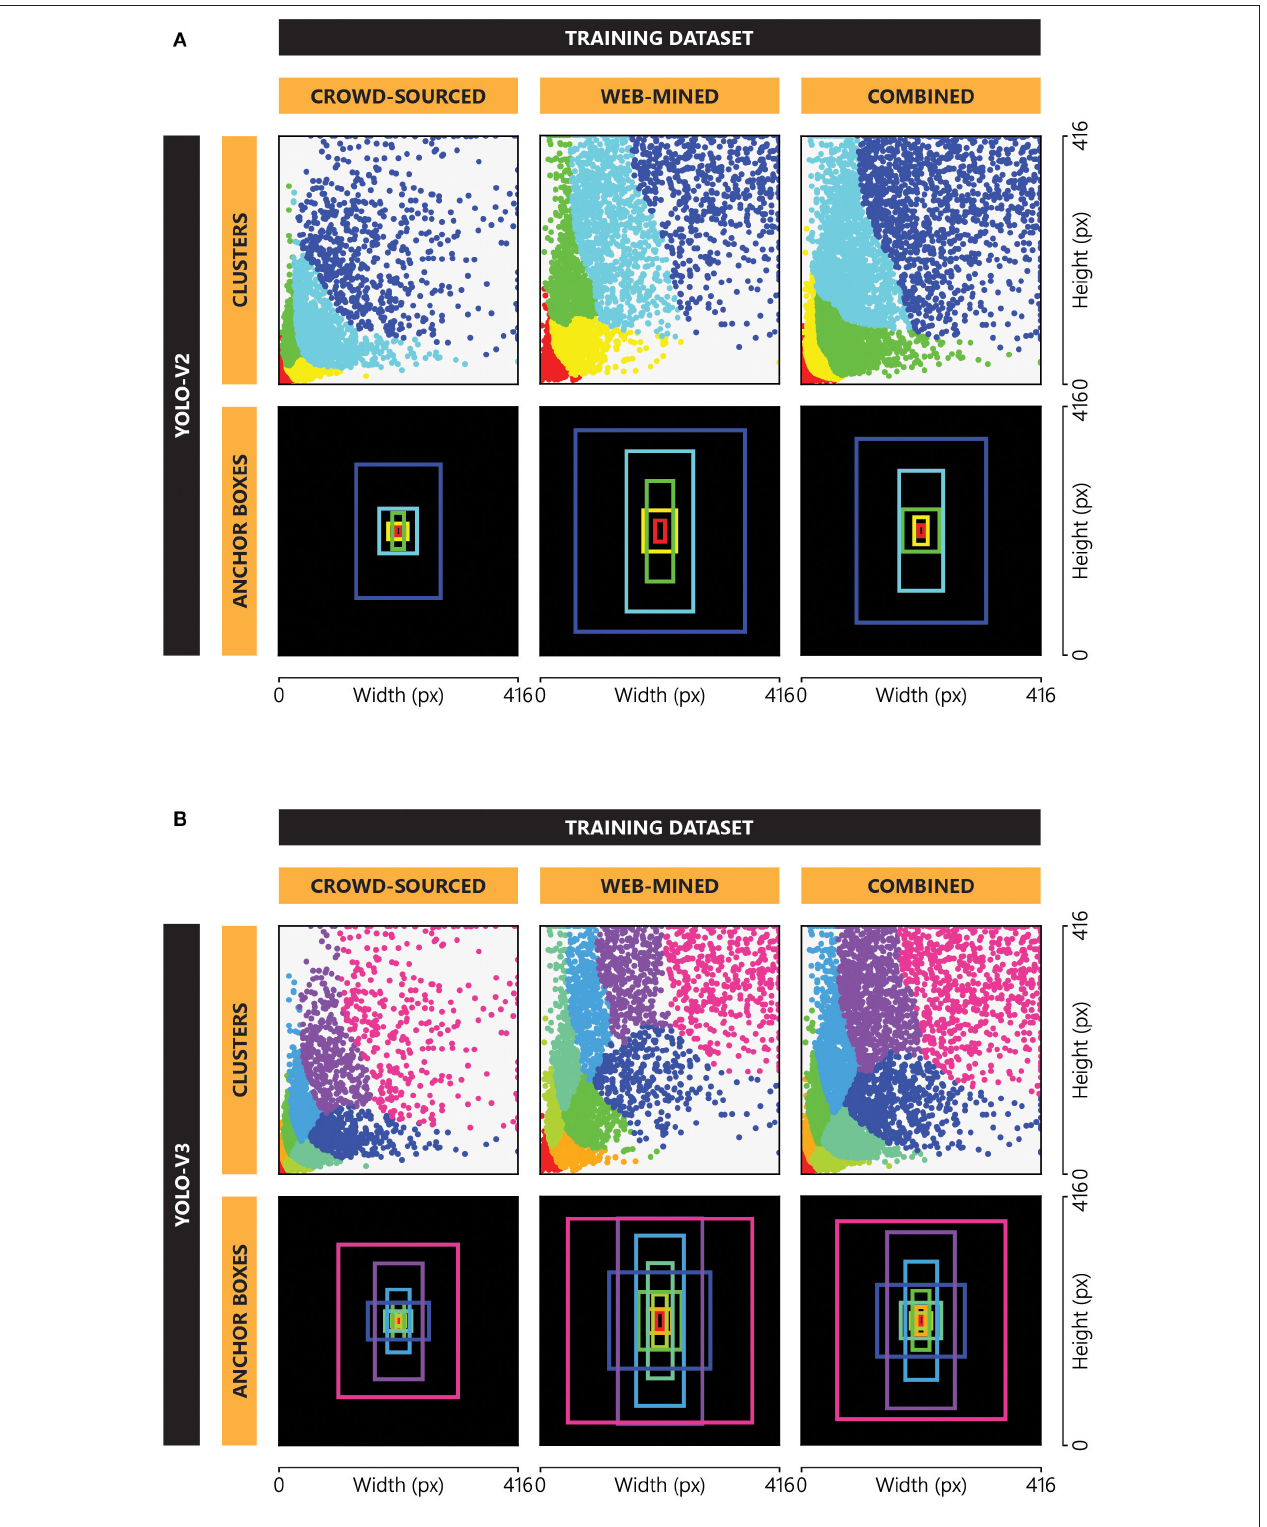
FIGURE 7 | Clusters and corresponding anchor boxes for (A) YOLO-v2 and (B) YOLO-v3 implementation.